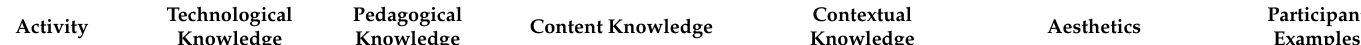
Table A2. Sample of the qualitative codebook for the decahedron and rectangular puzzle